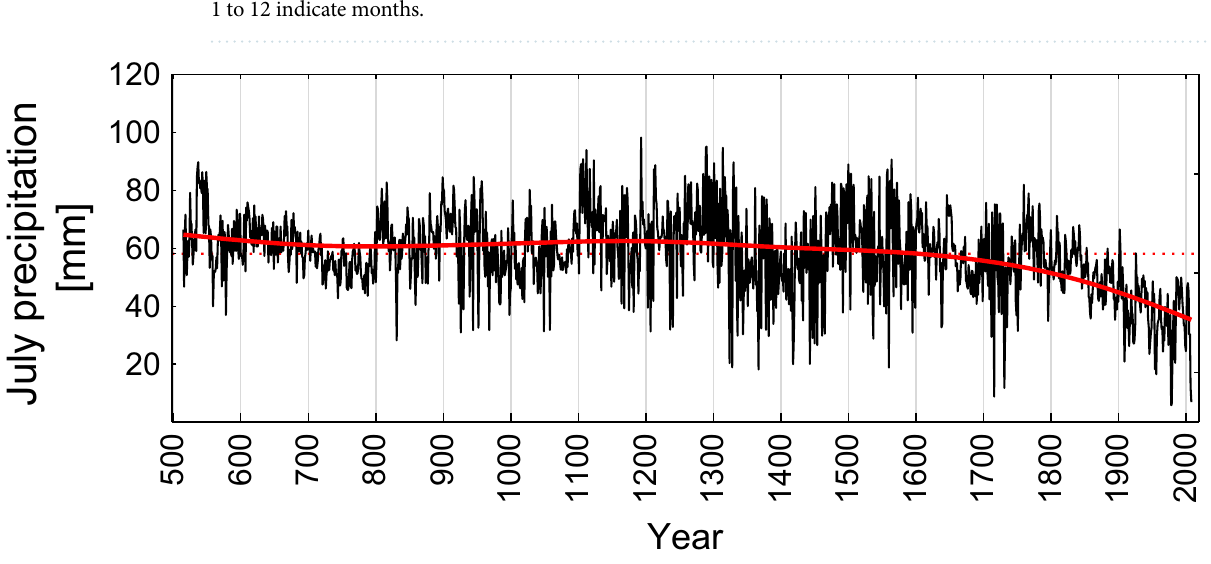
Figure 2. Correlation coefficients calculated between climatic parameters (temperature—T; Arctic Oscillation index—AO and precipitation—P) and the δ 13 C cell ( a ) and δ 18 O cell ( b ) chronologies over the common period of observations from 1969 to 2009 CE. Dashed red lines represent a level of significance at P < 0.05. Numbers from 1 to 12 indicate months.